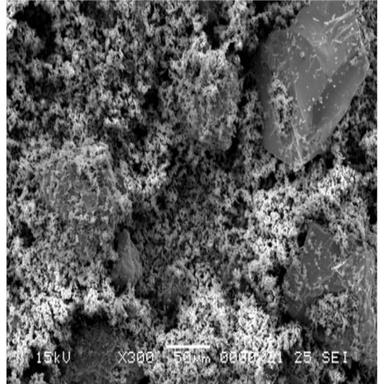
SEM images for starting sample and ball-milled powders in dry and wet milling conditions: a - starting sample (SS); b - 5 h wet-milled sample; c - 5 h dry-milled sample; d - 40 h wet-milled sample; e - 40 h dry-milled sample.